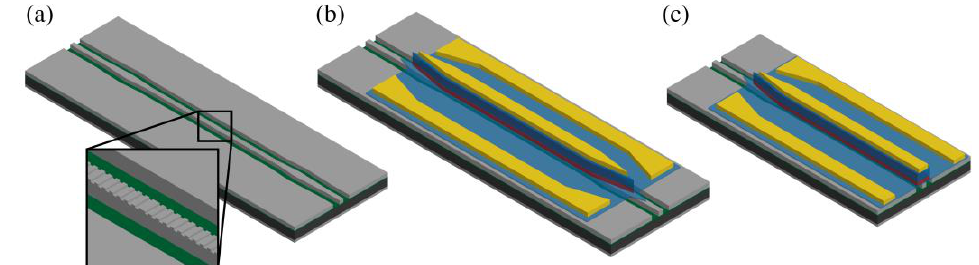
Figure 1. A 3D schematic of: ( a ) a SONOI waveguide with shallow surface DFB grating, which lies underneath the integrated QCL; ( b ) a DFB QCL heterogeneously integrated with a SONOI waveguide, including III-V tapers on both sides of the laser designed to transfer light from the hybrid Si/III-V active region to passive SONOI waveguides; ( c ) an integrated DFB QCL with one taper removed to expose a polished hybrid Si/III-V facet.